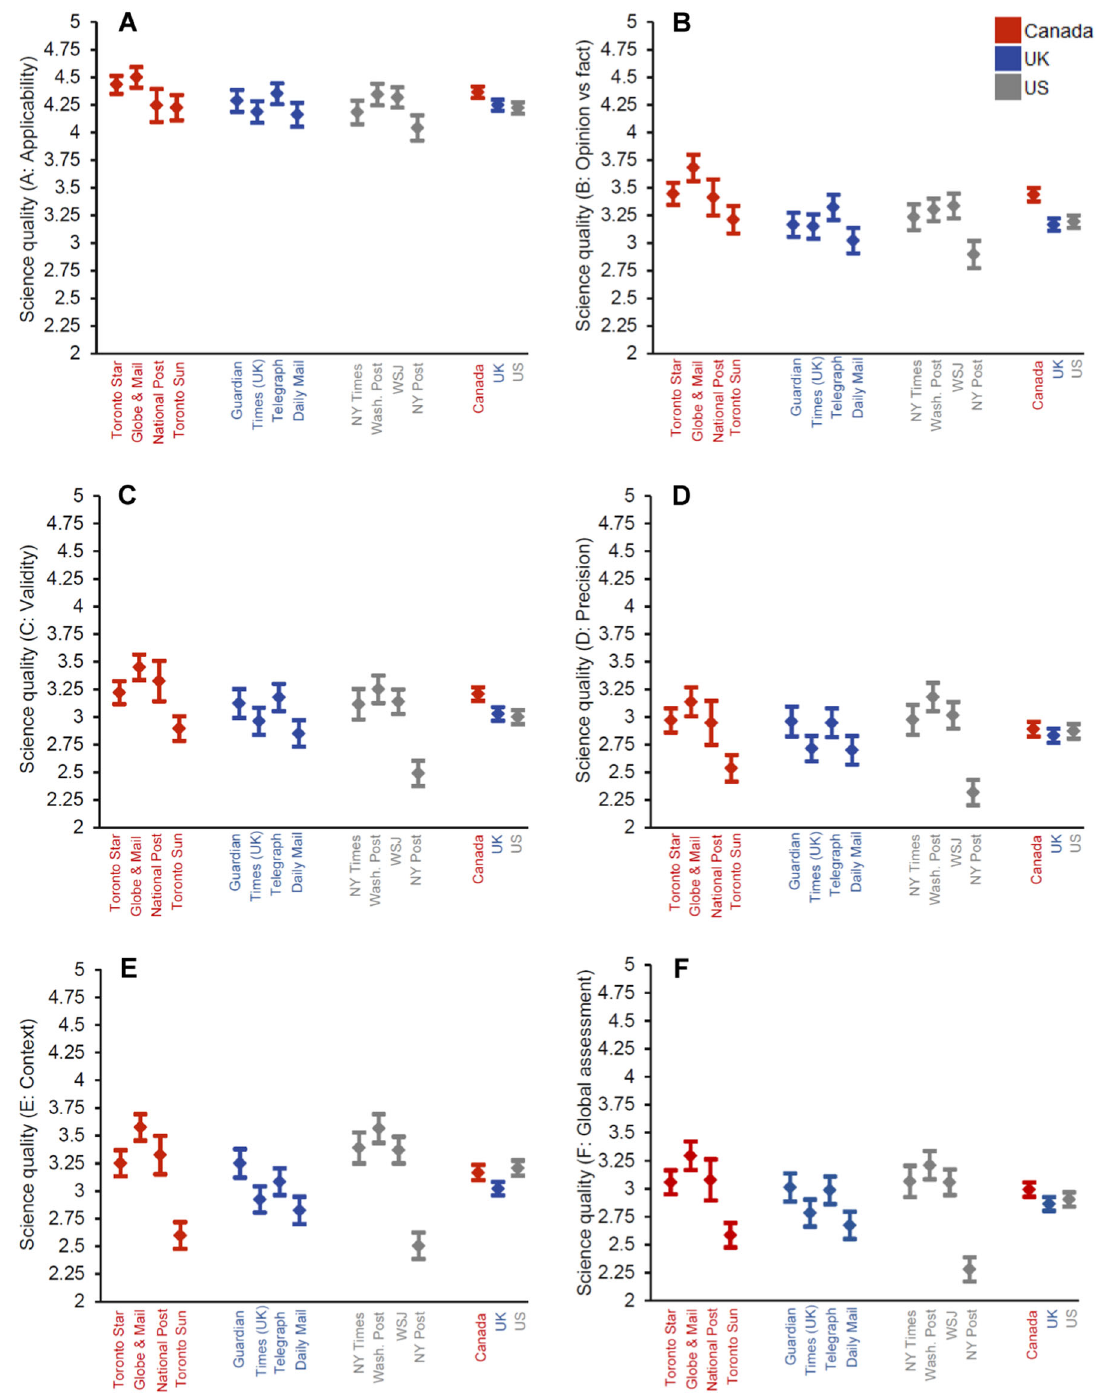
Fig. 3 Scienti fi c quality of news media articles by news outlet and country of publication. Scores for six scienti fi c quality questions (SI Coding Tool) are shown (mean, 95% con fi dence interval) for articles ( n = 1331) communicating COVID-19 public health or policy information (Fig. 2): ( A ) applicability, ( B ) opinion versus facts, ( C ) validity, ( D ) precision, ( E ) context, and ( F ) global assessment (i.e., an overall assessment of the article ’ s scienti fi c quality). Each question was evaluated on a scale from 1 to 5 (5 corresponding to highest scienti fi c quality). Sampled articles were published between 1 March and